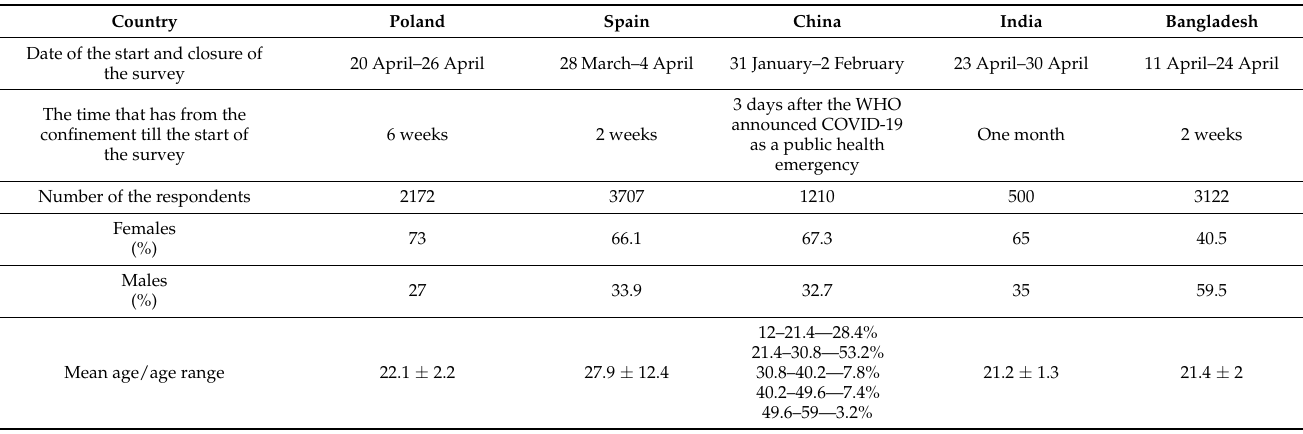
Table 6. The comparison of the results obtained applying the DASS-21 scale on a population of students in the studies performed in Poland, Spain, China, India, and